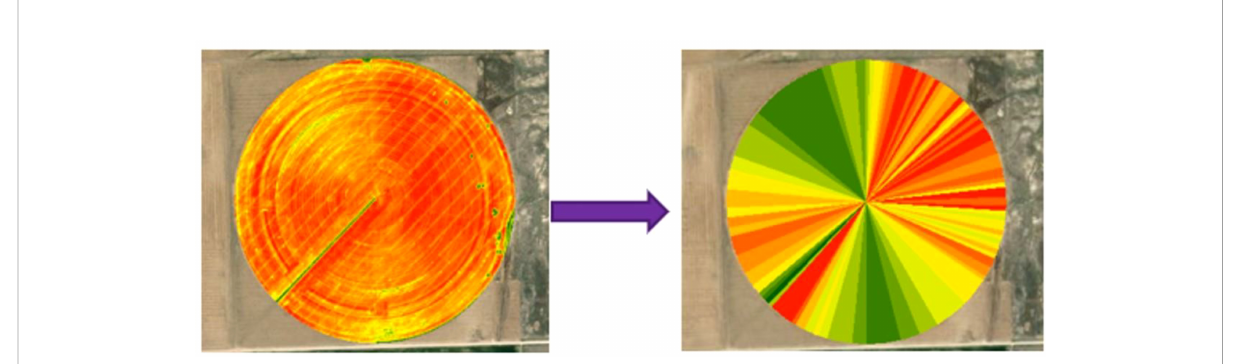
FIGURE 7 Weekly ET maps (left) are aggregated into variable speed control zones (right) using the mean of all pixels within each